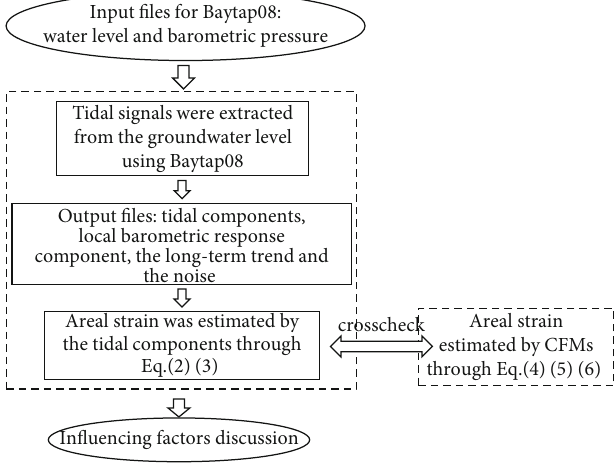
Figure 7: A fl owchart of the analysis